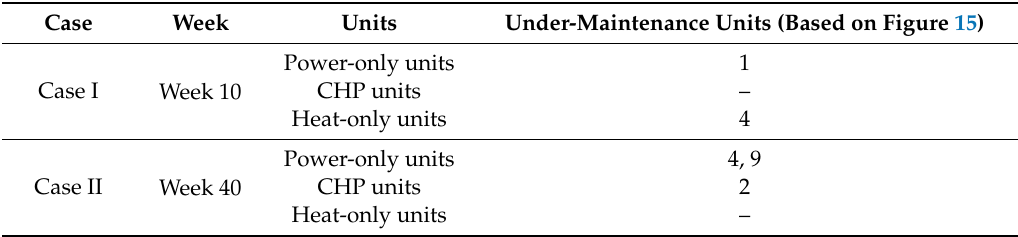
Table 14. Under-maintenance units in the selected weeks.